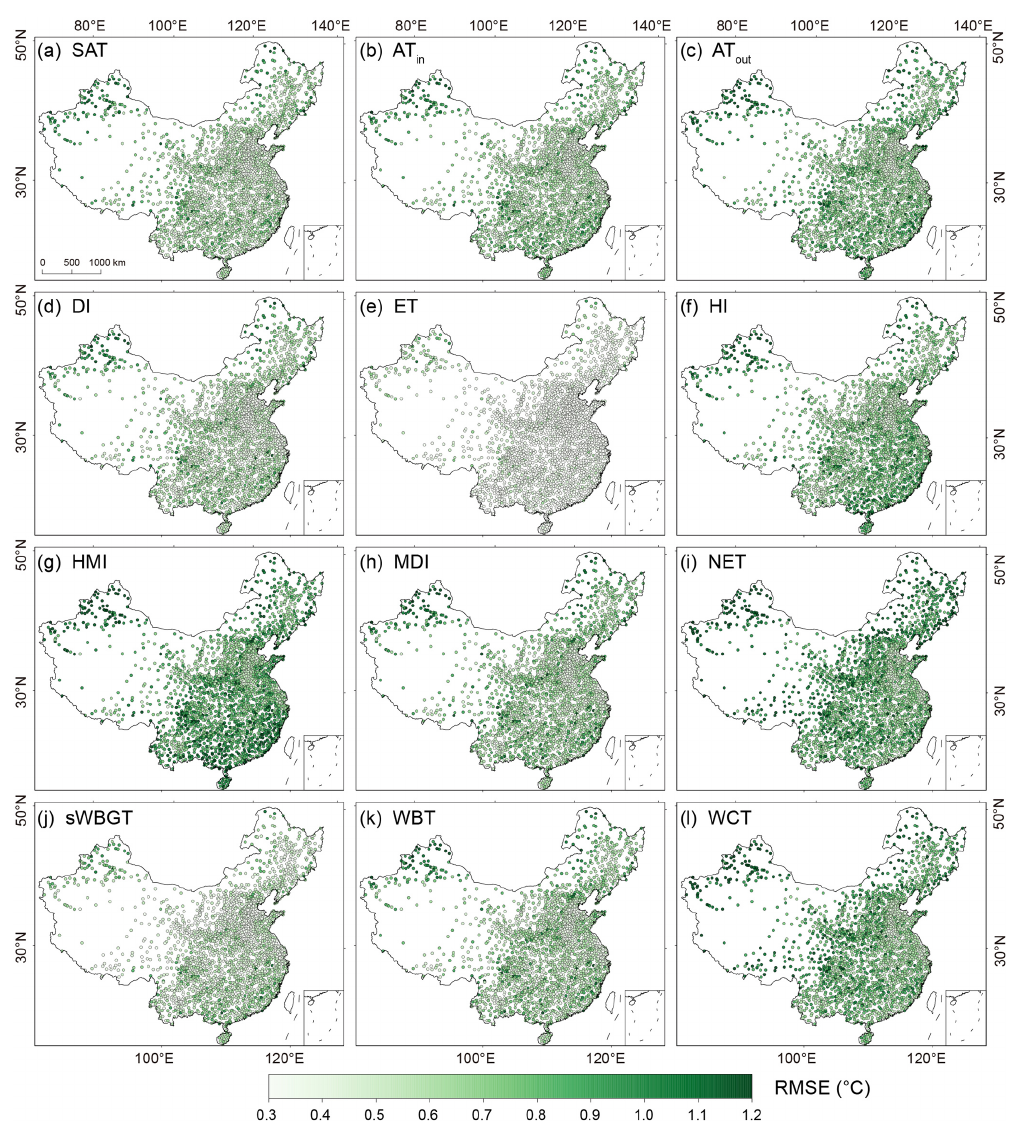
Figure 6. As Fig. 4 but for